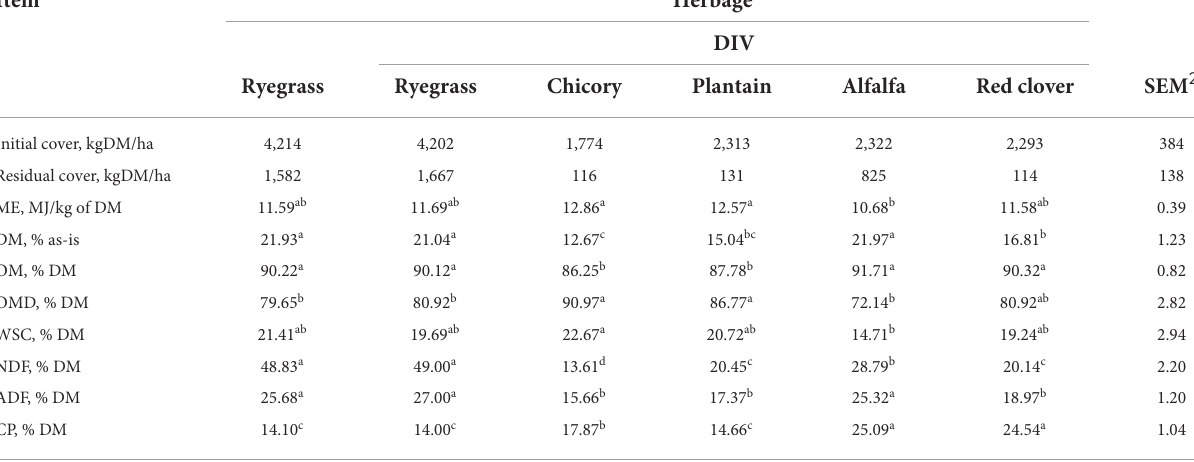
TABLE 2 Chemical composition of the herbage composing the single forage perennial ryegrass diet ( Lolium perenne L. ; Rye) or a taxonomically diverse multi-forage choice (DIV) diet of ryegrass, chicory ( Cichorium intybus L.), alfalfa ( Medicago sativa L.), plantain ( Plantago lanceolata L.), and red clover ( Trifolium pretense L.).